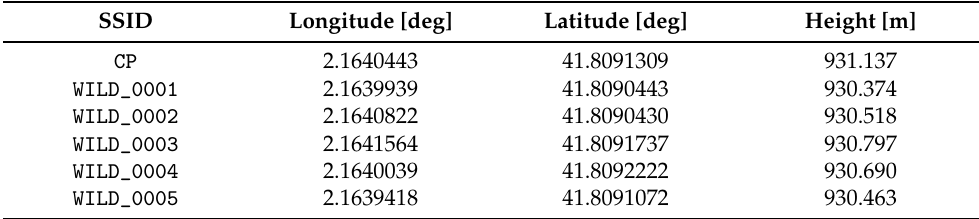
Table 1. Reference position (ETRS89 reference frame) of the Wifi Access Points, surveyed with a Septentrio AsteRx GNSS receiver.